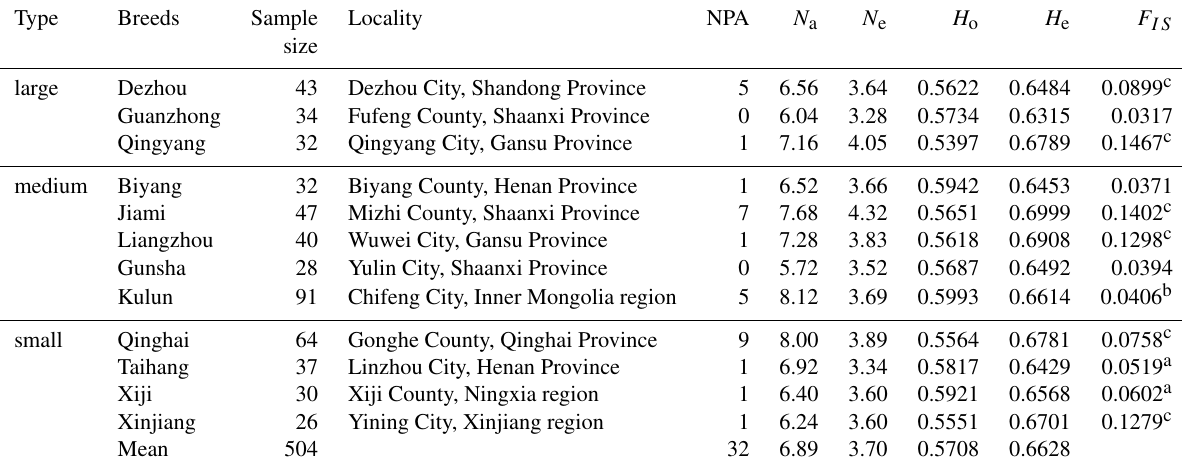
Table 1. Basic parameters for the genetic diversity associated with 12 donkey breeds. Type Breeds Sample Locality NPA H e F IS